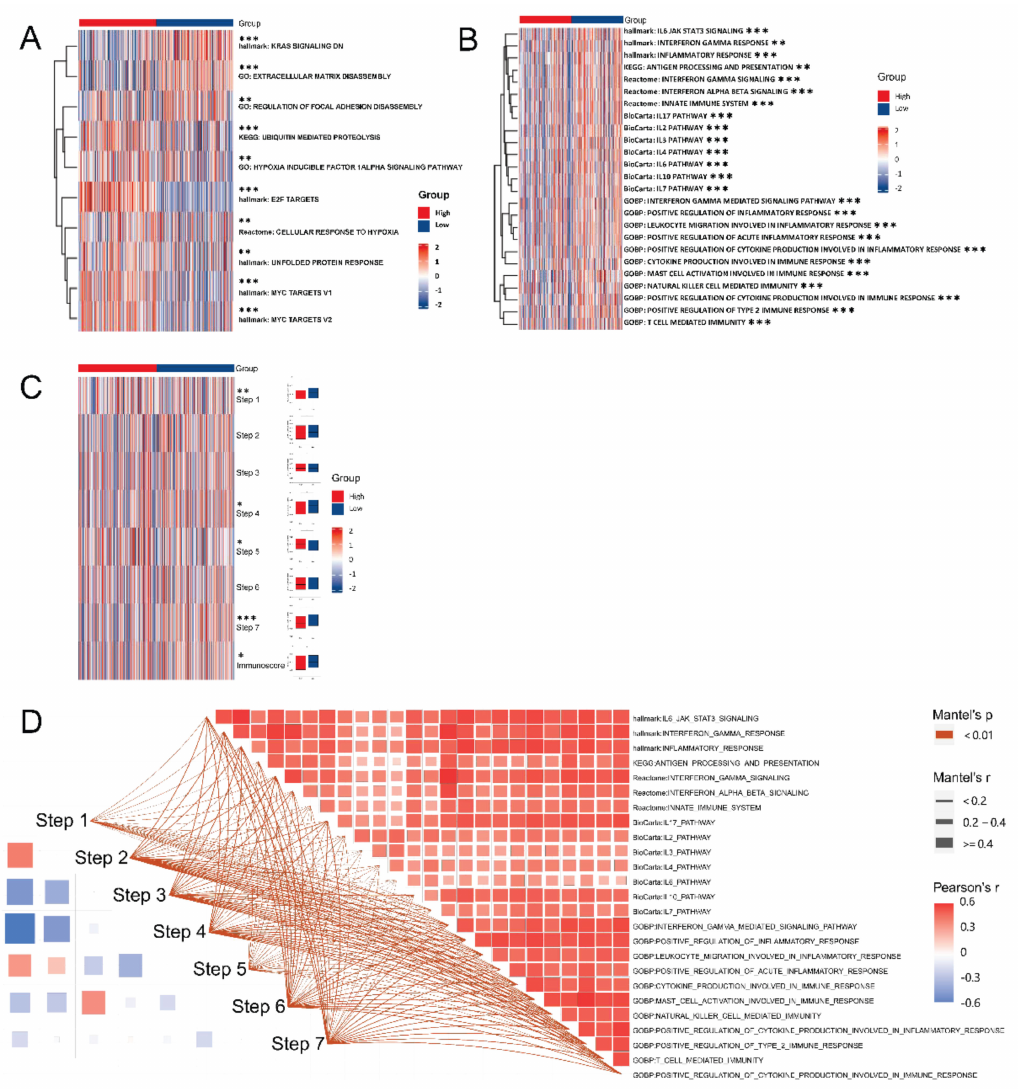
Figure 11. EZH2-associated GSVA: ( A , B ) GSVA of hallmark, BioCarta, KEGG, Reactome, and GO gene sets in EZH2 high- and low-expression samples from TCGA-PRAD database; ( C ) GSVA of 7-step Cancer-Immunity Cycle and Immunoscore in EZH2 high- and low-expression samples from TCGA-PRAD database; ( D ) Correlations between and within the MSigDB immune-related biological processes and pathways and 7-step Cancer-Immunity Cycle. p -values < 0.05, 0.01, and 0.001 were presented as “*”, “**”, and “***”,